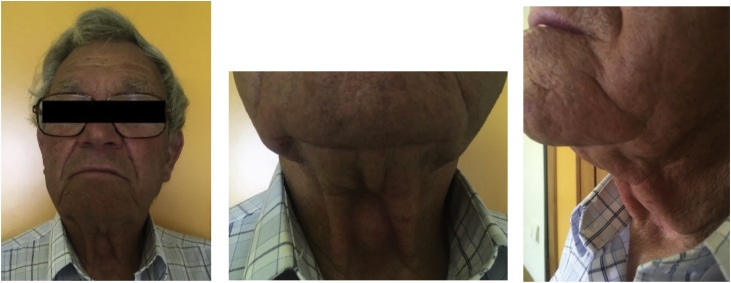
5 months follow-up.